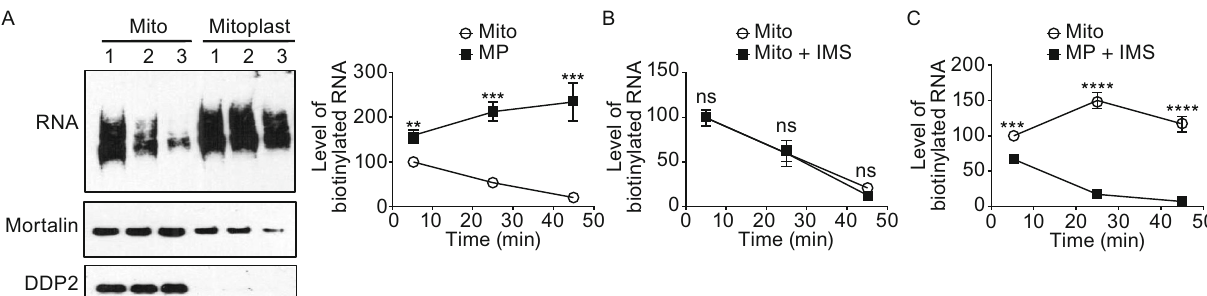
Figure 3. mtRNAs are degraded in the mitochondrial IMS. (A) Effect of mitoplasting on in organello mtRNA degradation. The three numbers (1, 2, and 3) represent three time points (5 min, 25 min, and 45 min). Top panel on the left shows the labeled mtRNAs. Middle panel is an immunoblot of mitochondrial matrix protein Mortalin showing the amount of mitochondria taken out at each time point with intact inner membrane. Bottom panel is an immunoblot of mitochondrial IMS protein DDP2 showing the ef fi ciency of mitoplasting. Right panel shows the quanti fi cation of the remaining labeled mtRNAs normalized to Mortalin signal ( n = 3). (B) Effect of adding isolated IMS (0.15 mg/mL) on in organello mtRNA degradation in intact mitochondria. (C) Effect of adding isolated IMS (0.15 mg/mL) on in organello mtRNA degradation in mitoplasts. Statistical comparisons are performed using unpaired t -tests ( n = 3 if not speci fi ed); * P < 0.05, ** P < 0.01, *** P < 0.001, **** P < 0.0001. Data are presented as mean ± standard error of the